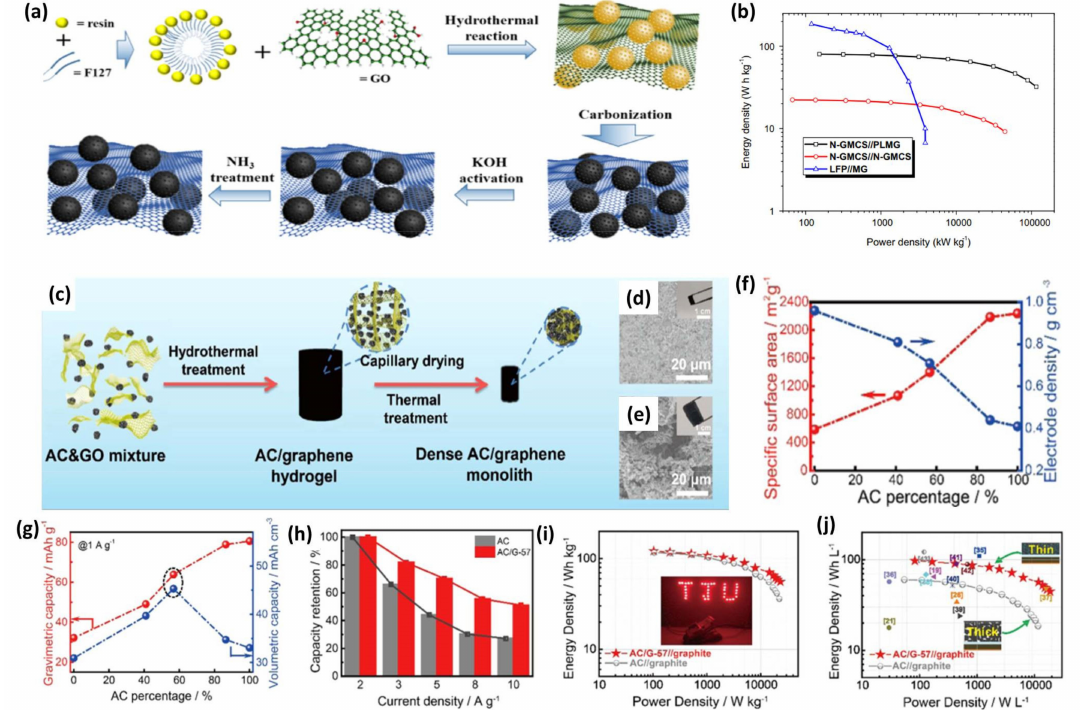
Figure 12. ( a ) Schematic of the synthesis of the NGMCS nanocomposite; ( b ) TEM image of the N-GMCS nanocomposite. (Reprinted with permission from Ref. [130]. Copyright 2015 Elsevier.) ( c ) Schematic of the AC/G composite monolith fabrication process; SEM images of ( d ) the capillary drying-induced dense AC/G monolith and ( e ) the freeze-drying- induced AC/G hydrogel; ( f ) The SSA and electrode density variations of the AC/G composites with the percentage of AC; ( g ) The relationship between the gravimetric/volumetric capacity and the percentage of AC in the AC/G composites; ( h ) Comparison of the capacity retention of pure AC and AC/G-57 electrodes at various current densities; Ragone plot of the AC/G-57//graphite LIC compared with the AC//graphite LIC based on ( i ) mass and ( j ) volume. (Reprinted with permission from Ref. [131]. Copyright 2019